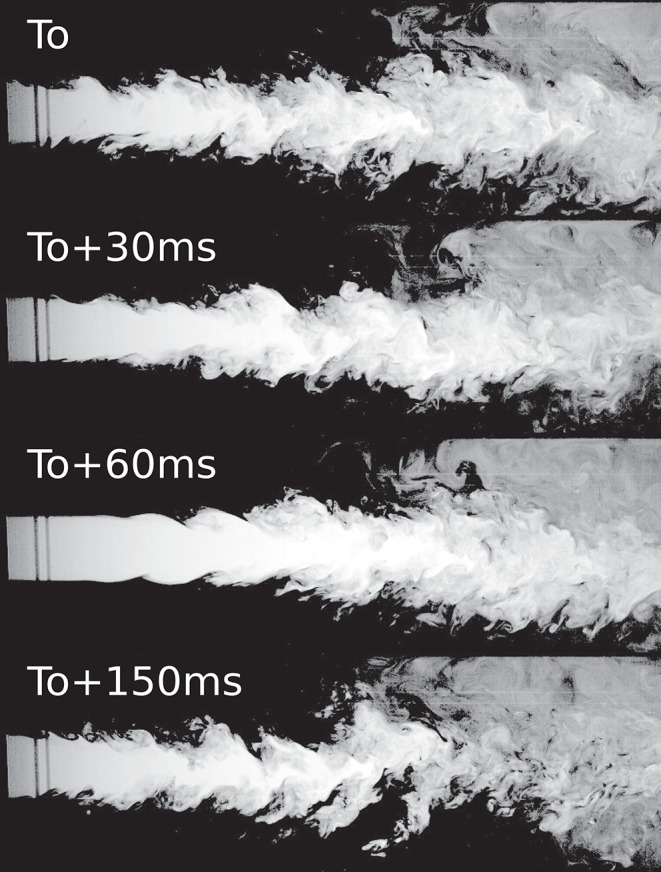
Case 1LC for which a transitional flow was observed. The figure shows four consecutive time instances highlighting how the flow went from turbulent to laminar and turning turbulent again.